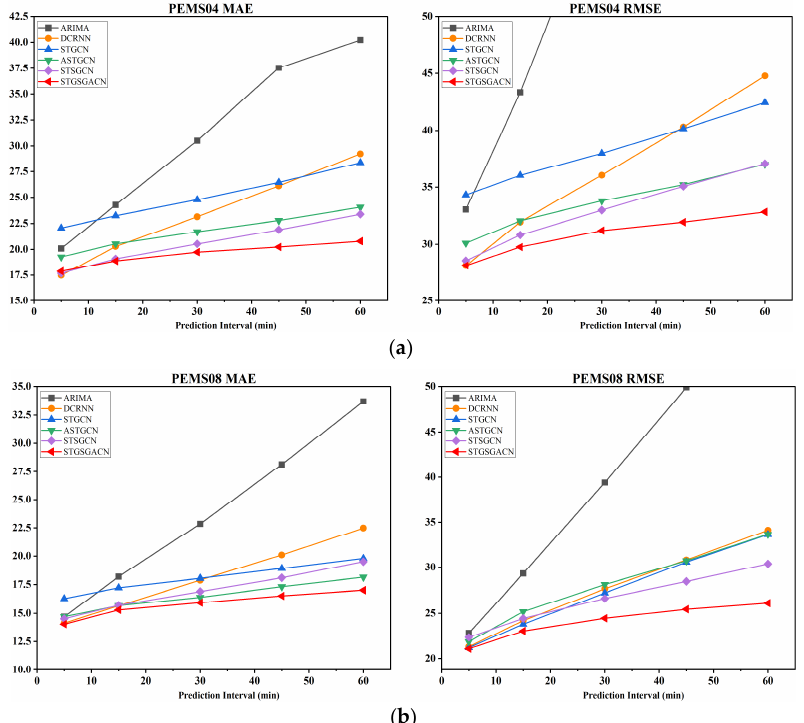
Figure 12. Prediction the performance of different methods with increasing prediction time intervals. ( a ) The prediction results of different methods on the dataset PEMS04. ( b ) The prediction results of different methods on the dataset PEMS08.